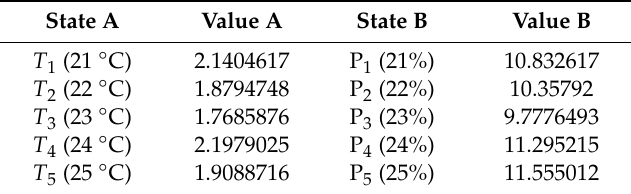
Figure 16. Variation of optimal values of QoS and energy saving per iteration and γ . Table 18. Estimated optimal value function table ( γ :